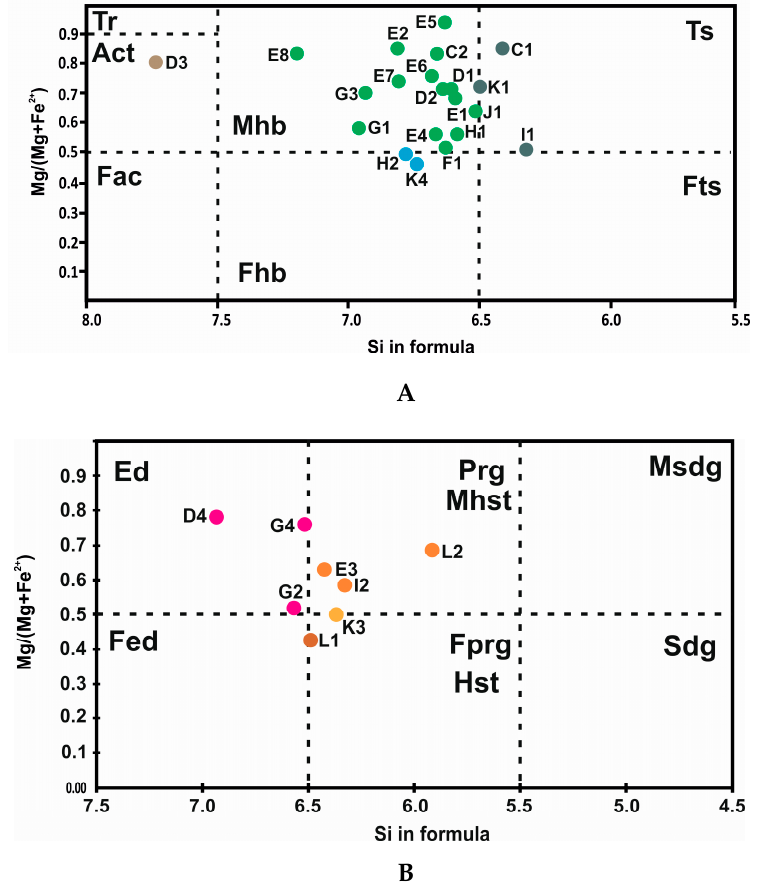
Figure 13. A (upper diagram) shows the presence of magnesio-hornblend (Mhb), tschermakite (Ts), ferro-hornblende (Fhb) and actinolite (Act). In this diagram tremolite (Tr), ferro-actinolite (Fac) and ferro-tschermakite (Fts) were not found. B (lower diagram) shows the presence of pargasite (Prg), edenite (Ed), magnesio-hastingsite (Mhst), and hastingsite. In this diagram ferro-edenite (Fed), magnesio-sadanagaite (Msdg) and sadanagaite (Sdg) were not found. The capital letters next to each dot indicates the location of the sample on the map of the Figure 10. Each number next to each capital letter is the reference of the analyzed mineral grain. These diagrams project chemical analysis data of calcic amphiboles from samples collected from the Northern Portuguese continental shelf.